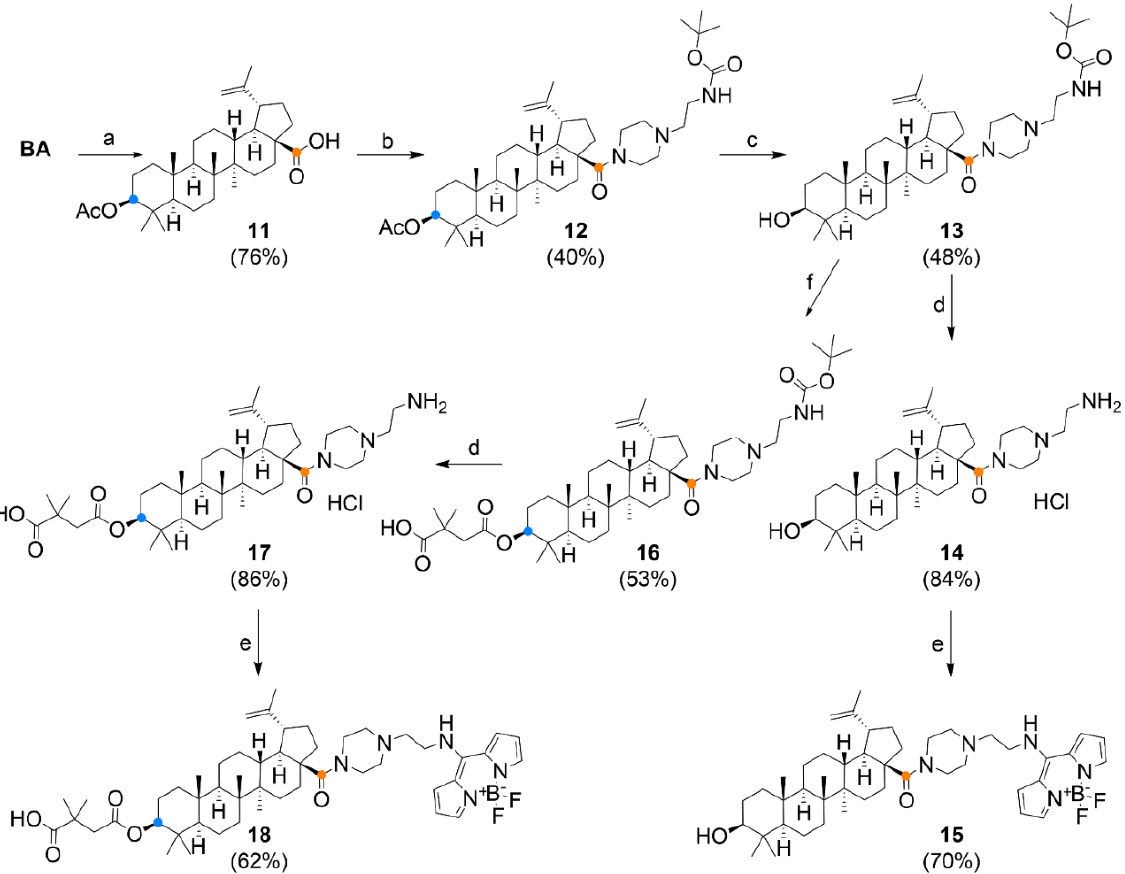
Figure 4. Synthesis of “piperazinyl” derivatives. Reagents and conditions: (a) Ac 2 O, pyridine, 12 h, RT; (b) i. (COCl) 2 , DCM, DMF, 2 h, RT, ii. 1-(2- N -boc-aminoethyl)piperazine, Et 3 N, DCM, 12 h, RT; (c) 4M NaOH, THF-MeOH, 3 h, RT; (d) 2M HCl/Et 2 O, 12 h, RT (under argon); e) BODIPY-SMe, CHCl 3 -THF, Et 3 N, 30 min, RT; (f) 2,2-dimethyl succinic anhydride, 4-DMAP, p -TsOH, THF, 2 h, MW-130 °C.